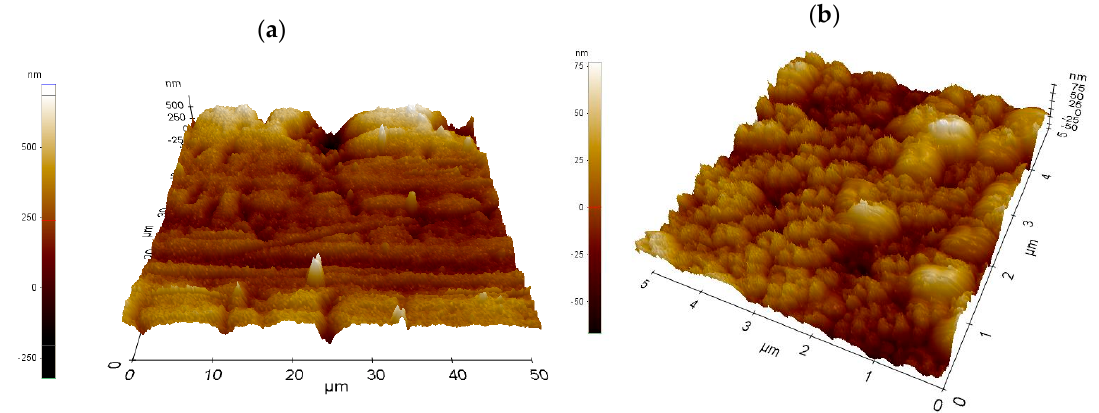
Figure 4. Surface topography of oxidised copper sheets: ( a ) L1-1; ( b ) L2-4.